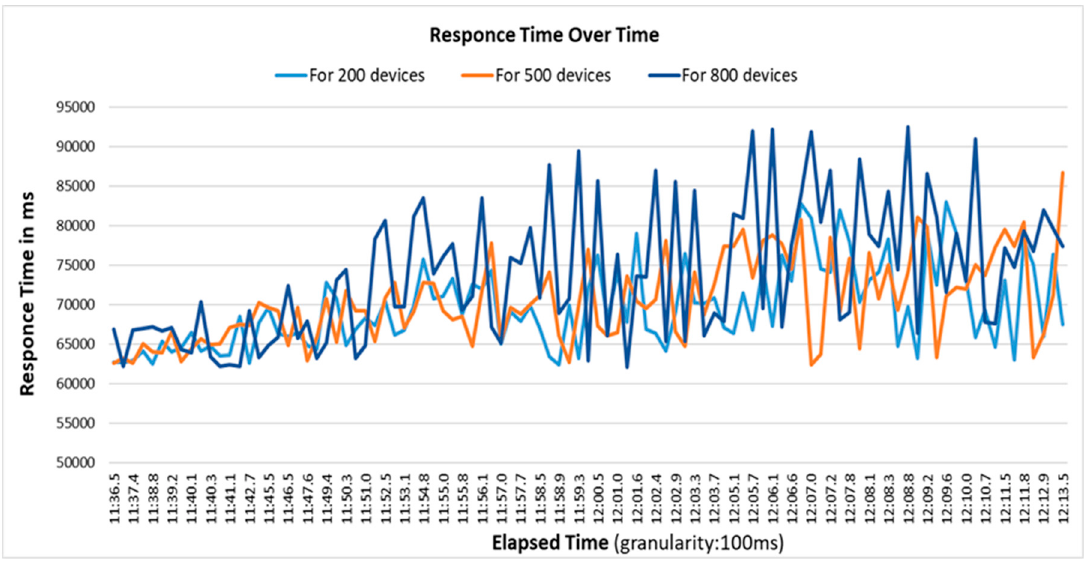
Figure 15. Device registration response time in a different simultaneous request.